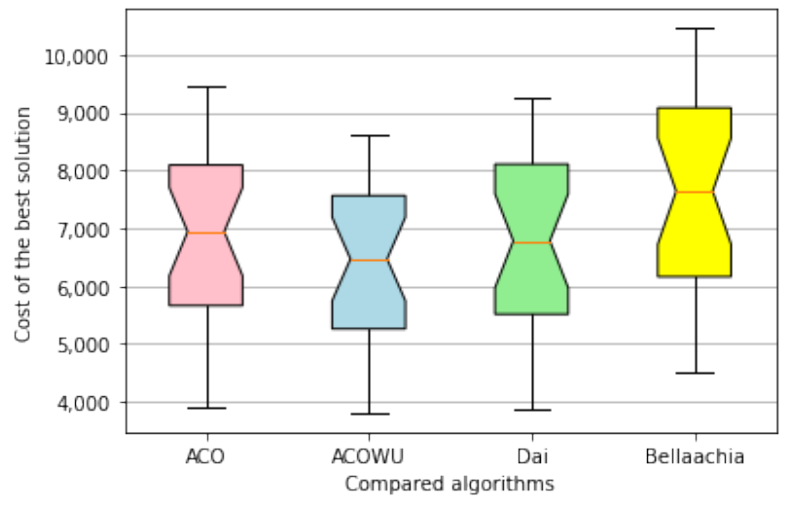
Figure 1. Comparison in terms of cost on generic TSP instances. Table 3. Results obtained on generic TSP instances in terms of solutions explored before finding best